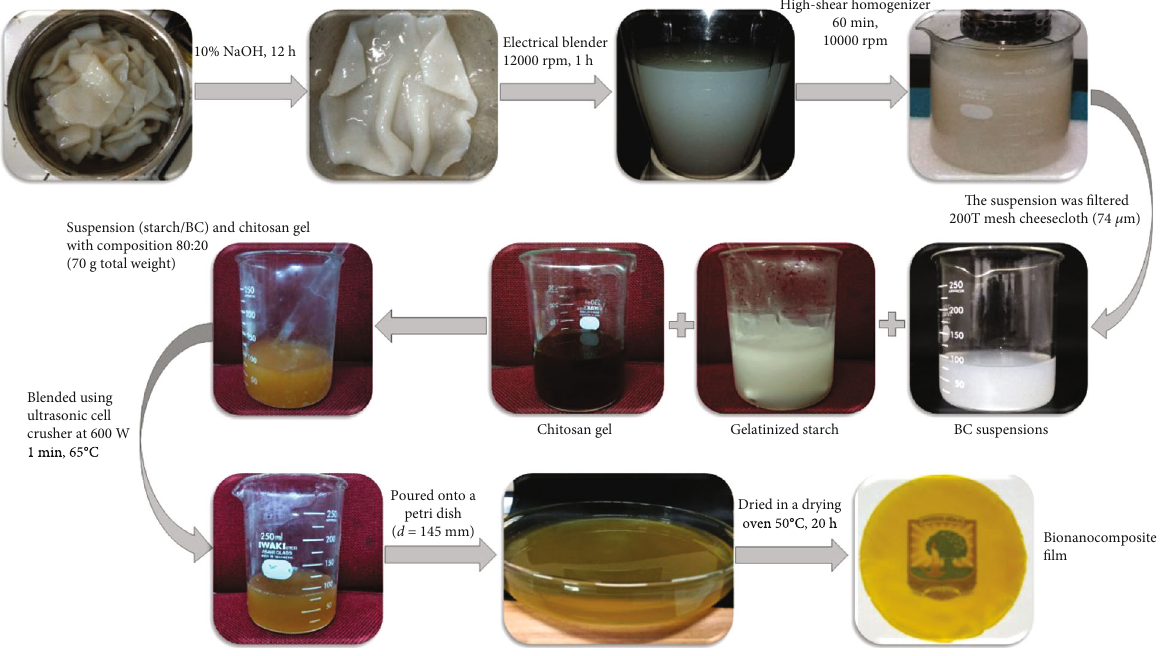
Figure 1: Steps of sample preparations for Table 1: Composition of the starch fi lm, chitosan fi lm, and biocomposite fi lms used in the study. Sample code